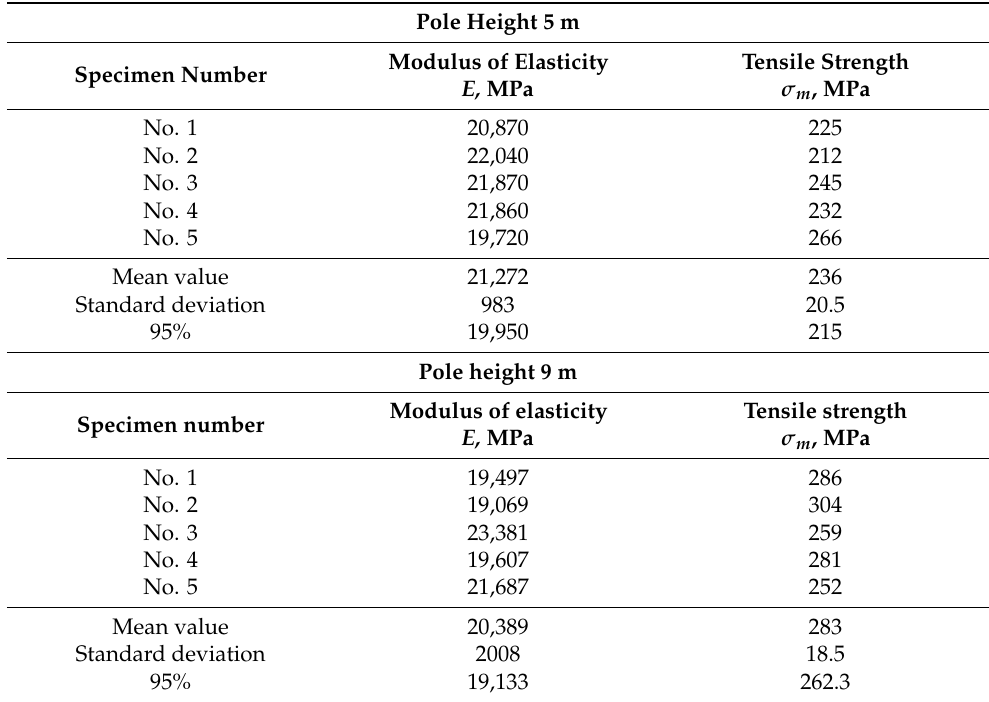
of the tested sample.